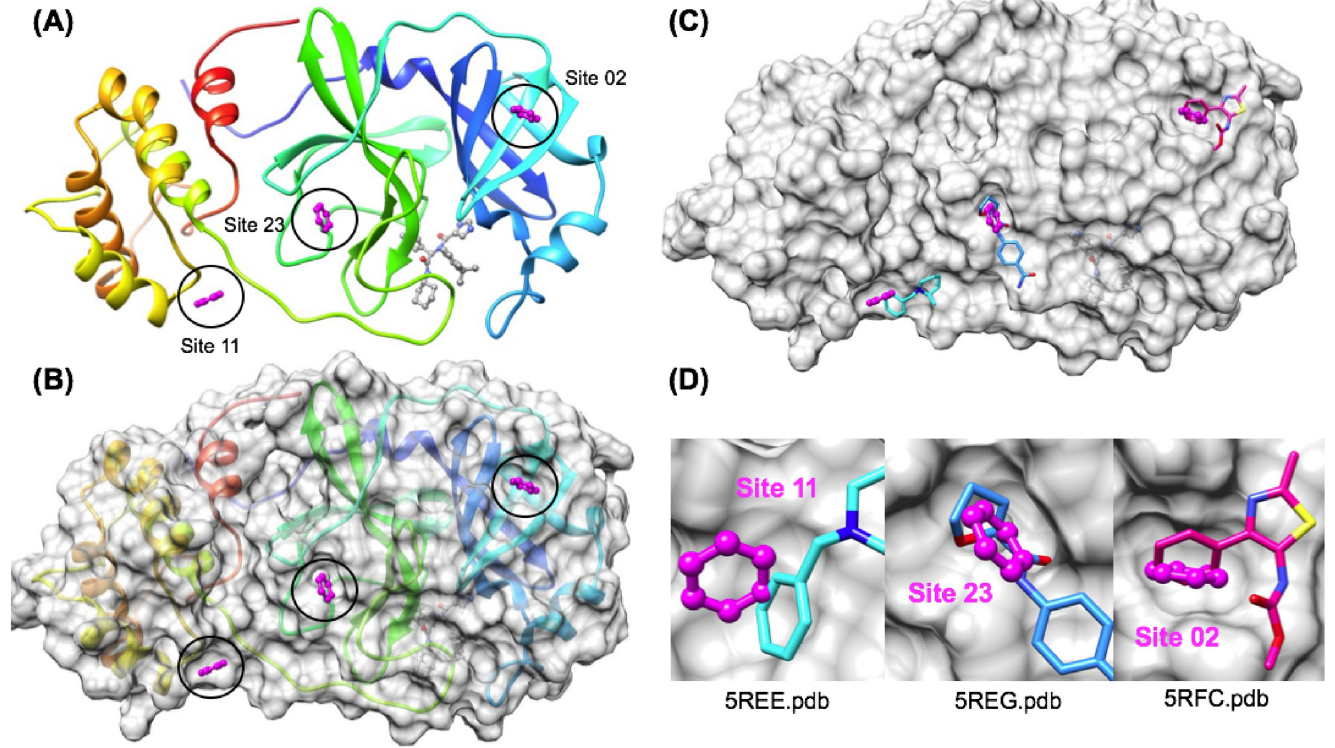
Fig 7. Experimental structures from fragment screening confirm other Nsp5 Mpro “minor” binding sites successfully predicted. The crystal structure of Nsp5 Mpro (6W63.pdb) is shown illustrating the reverse or “minor” binding surface using ribbon diagram with rainbow coloring (A) and is shown with a transparent gray surface in (B). Several crystal structures of other fragment ligands (5RFC.pdb, 5REE.pdb, 5REG.pdb) independently confirm the positions of the “minor” binding sites: Site 02, Site 11 and Site 23 pharmacophores shown in (C) and (D).